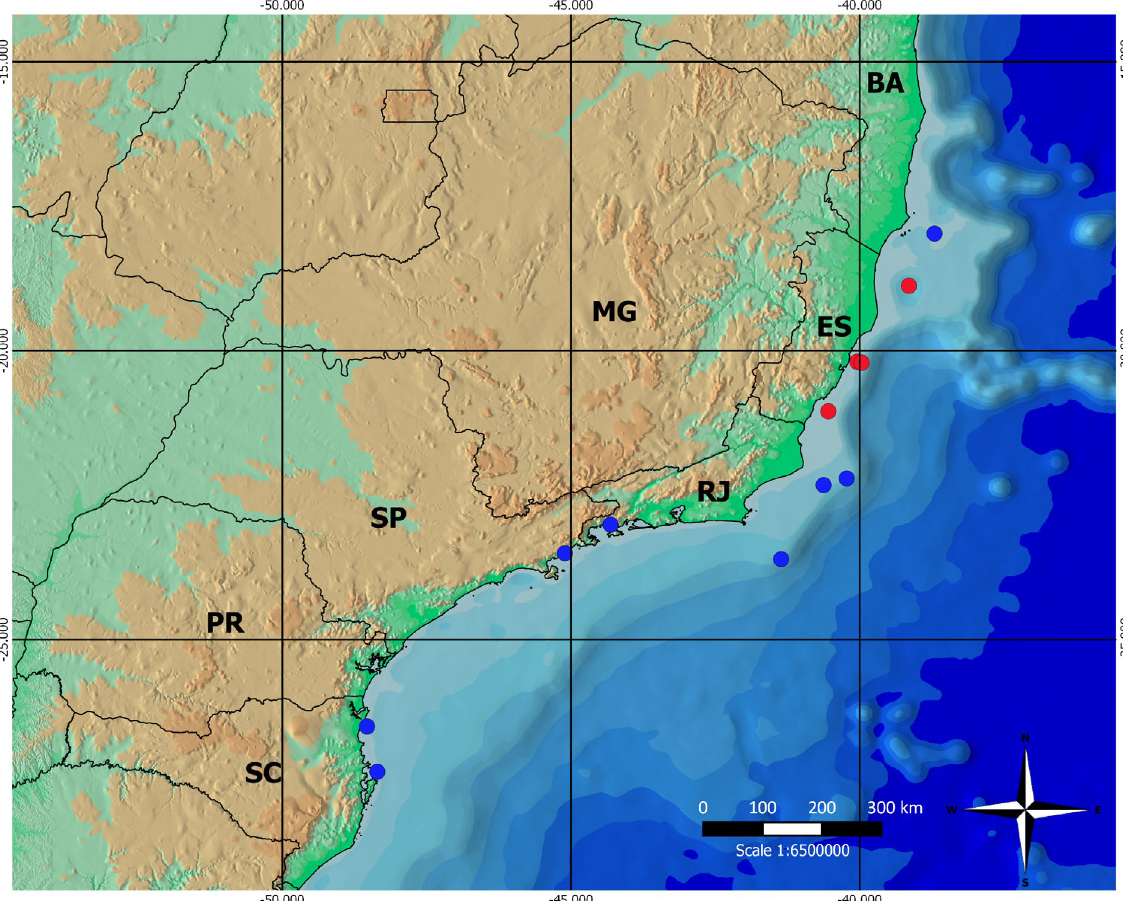
Fig. 7. Distribution of Phtisica marina Slabber, 1769 (blue dots) and Hemiproto wigleyi McCain, 1968 (red dots) along the Brazilian coast. Abbreviations: BA = Bahia; ES = Espírito Santo; RJ = Rio de Janeiro; SP = São Paulo; PR = Paraná; SC = Santa